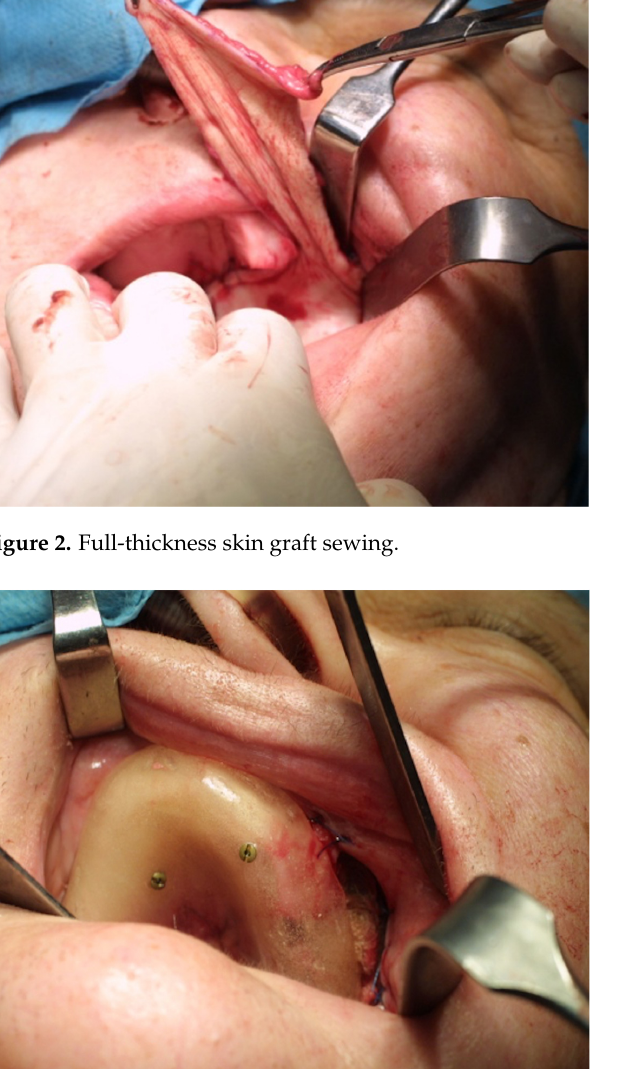
Figure 1. Free full-thickness skin graft harvesting from the groin area.